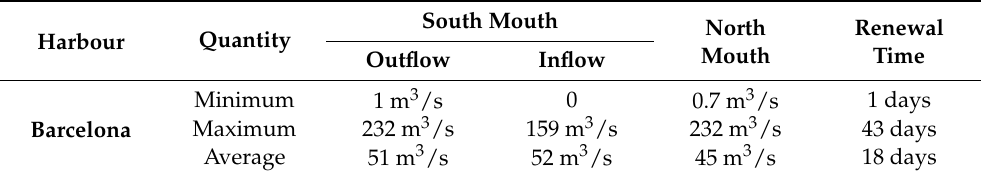
Table 7. Flows and Renewal Times (RT) calculated for Barcelona harbour from measured Doppler velocities during the field